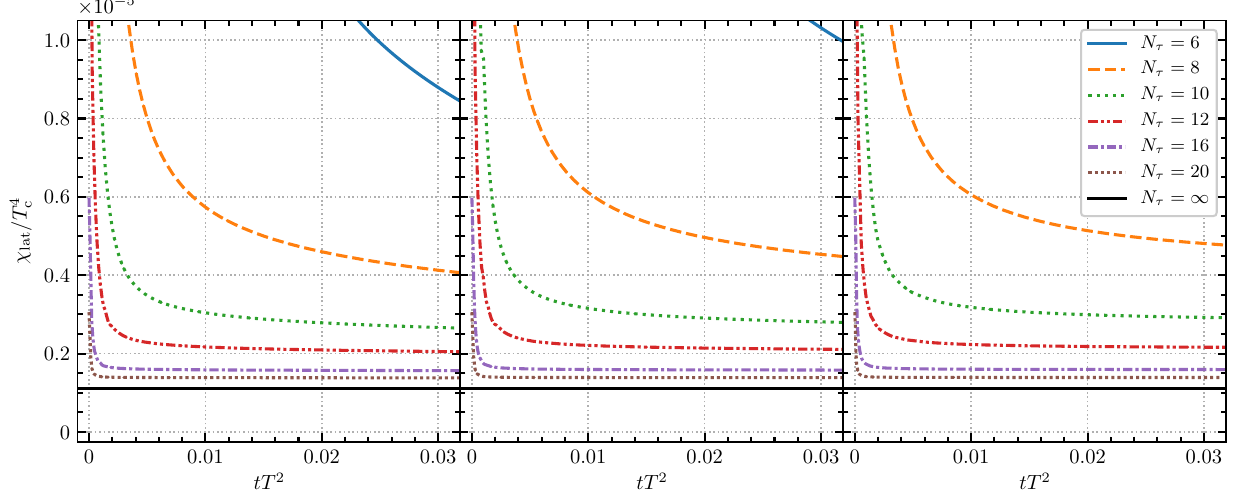
Fig. 6 Estimated effect of lattice artifacts on the topological susceptibility, at T / T c = 4 and for N τ = 6 , 8 , 10 , 12 , 16 , 20, as a function of the